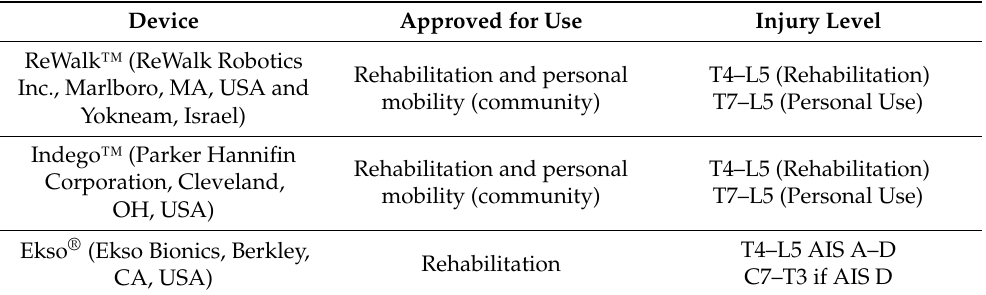
Table 1. Robotic exoskeletons approved for rehabilitation by the Food and Drug Administration.